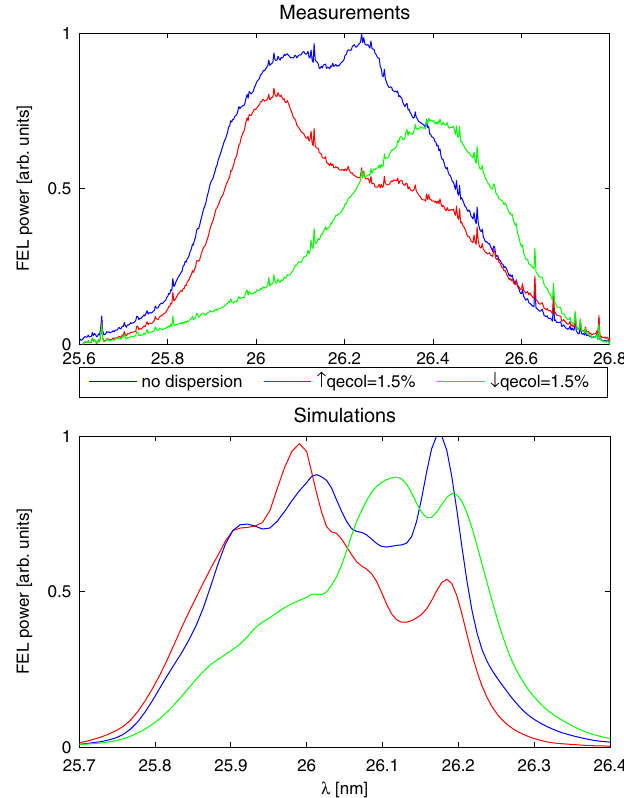
FIG. 17. (Color) Measurements and simulations of dispersion effects to the radiation wavelength